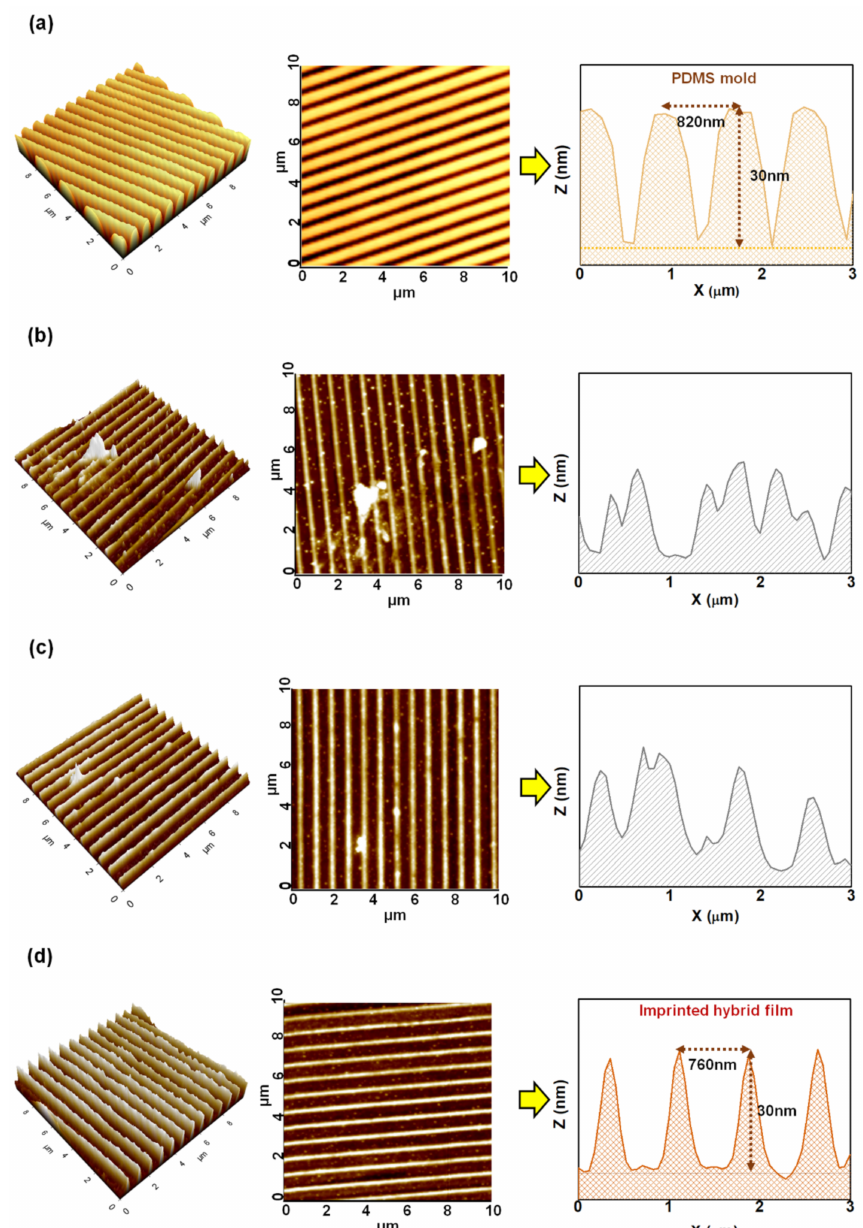
Figure 3. ( a ) PDMS mold and UV-nanoimprinted hybrid films 3-D ( left ), top-view ( middle ) AFM images, and corresponding line profiles ( right ) according to UV exposure time: ( b ) 1 min, ( c ) 3 min, and ( d ) 6